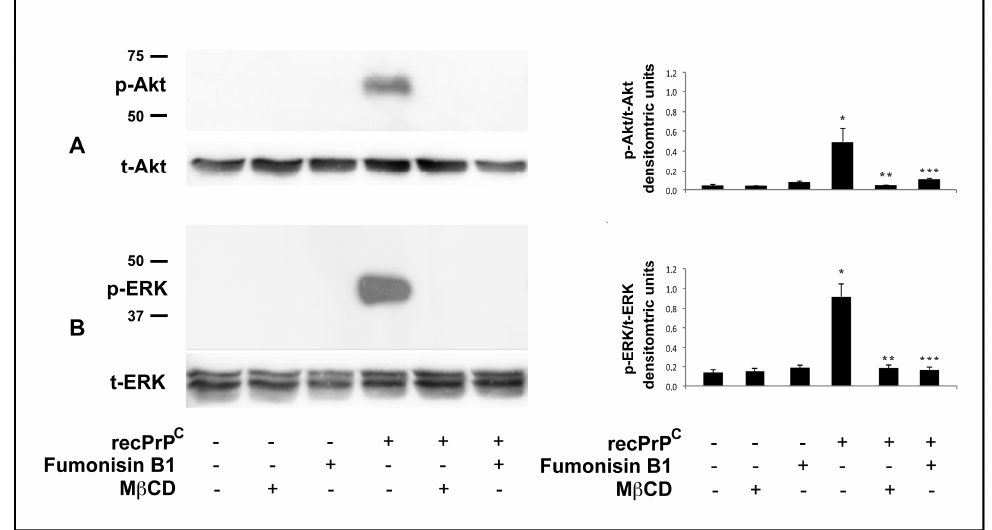
Figure 3. E ff ect of lipid rafts perturbation on Akt and ERK Phosphorylation induced by recPrP C . hDPSCs, untreated or treated with 0.5 µ g / mL of recPrP C for 10 min in the presence or in the absence of Fumonisin B1 or M β CD, were analyzed by Western blot using anti-pAkt and anti-total Akt ( A ). anti-pERK1 / 2 and anti-total ERK1 / 2 ( B ). Densitometric analysis is shown in the right panel. Results represent the mean ± SD from 3 independent experiments, * p recPrP C treated cells < 0.01 vs. untreated cells, ** p recPrP C treated cells + M β CD < 0.01 vs. recPrP C treated cells, *** p recPrP C treated cells + Fumonisin B1 < 0.01 vs. recPrP C treated